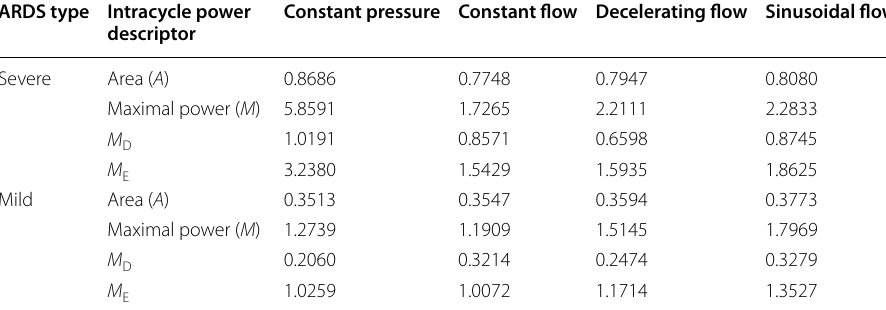
Maximal instantaneous power values are also displayed for the driving ( M D ) and elastic ( M E ) subcomponents of total power